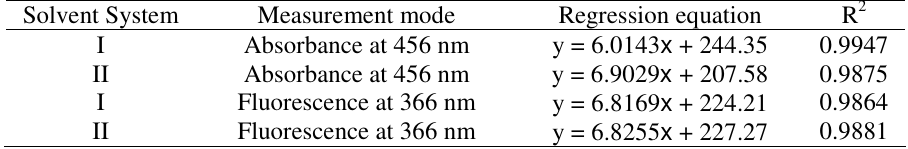
Figure 5. Linear calibration of sucralose derivatized with rhodamine-sulfuric acid reagent (y = 6.0143x + 244.35 ) by peak area of absorbance measurement at 456 nm in the range between 50 and 250 ng per band with relative standard deviation of the calibration plot ± 2.3% and correlation coefficient R 2 =0.9947 (Solvent system-I). Table 1. Comparison of the calibration data obtained for sucralose using two solvent systems after derivatization in different modes of measurement.